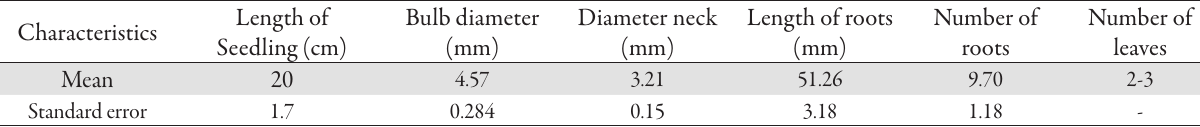
Tab. 2. Seedling characteristics (after 75 days)